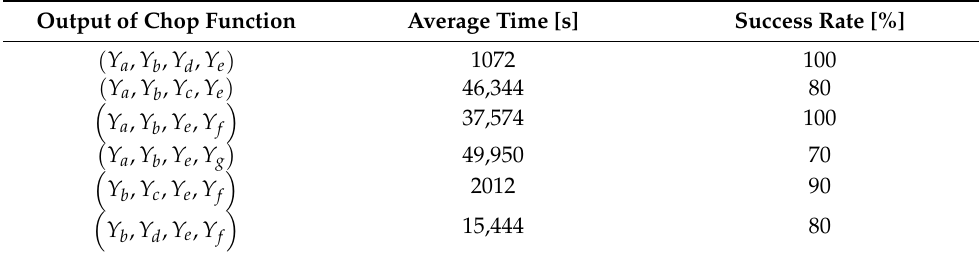
Table 4. Average time and success rate of the analysis for